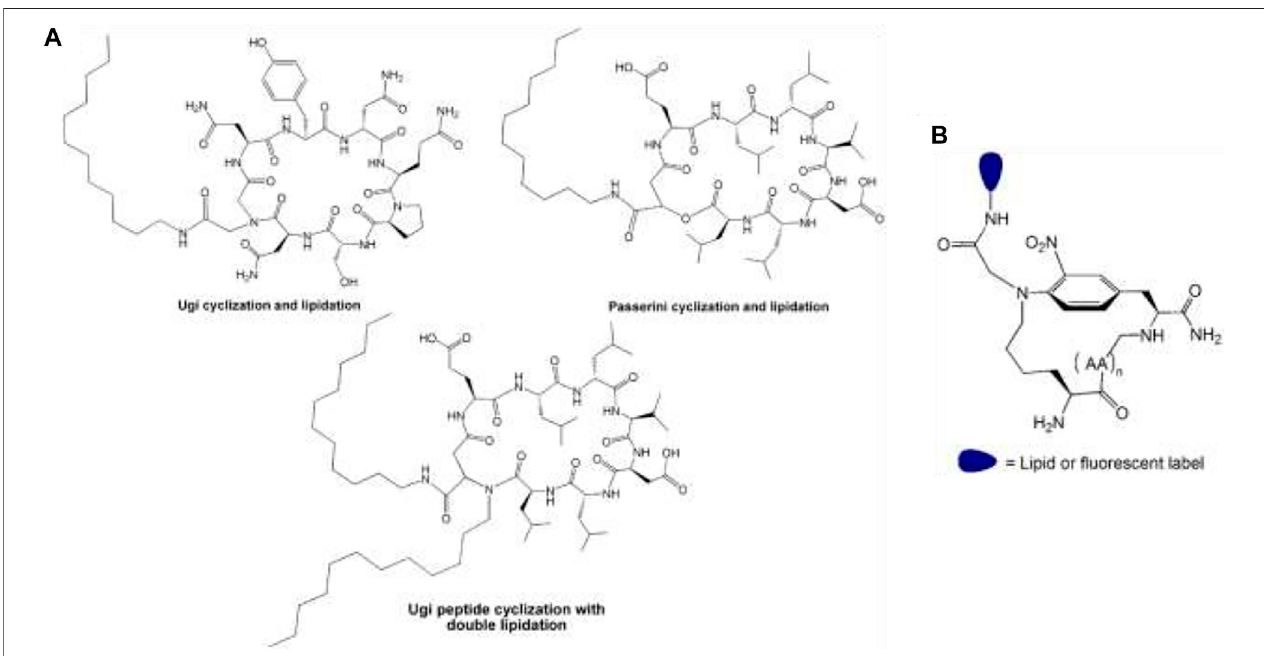
FIGURE 13 | (A) Peptide-steroid and peptide-lipid conjugates. Products of simultaneous cyclization and lipidation of peptides by Ugi and Passerini reactions. (B) The pattern of the product was obtained using resin Ugi-smiles macrocyclization and